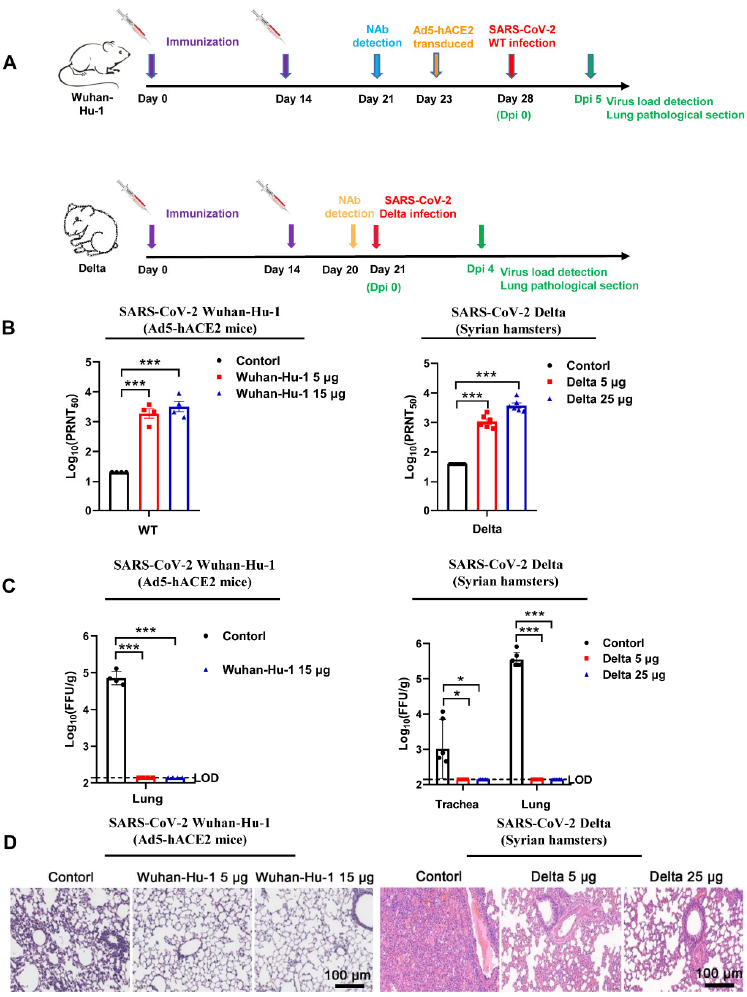
Figure 2. The Wuhan-Hu-1 and Delta vaccines exerted robust protection against SARS-CoV-2. ( A ) Experimental strategy. ( B ) Ad5-hACE2 mice (Wuhan-Hu-1; left panel) or Syrian hamsters (delta; right panel) were immunized twice with low-dose (5 µ g/dose) or high-dose (15 or 25 µ g/dose) of Wuhan-Hu-1 or Delta vaccine on day 0 and 14. The neutralizing antibody titers against SARS-CoV-2 in animals were tested by PRNT. Ad5-hACE2 mice, n = 4. Syrian hamsters, n = 6. *** p < 0.001 ( C ) Ad5-hACE2 mice or Syrian hamsters in the low- and high-dose groups were challenged with SARS-CoV-2 Wuhan-Hu-1 or Delta. The viral load was analyzed and expressed as FFU per gram of tissue in the lung (Ad5-hACE2 mice; at 4 dpi; left panel) or both lungs and trachea (Syrian hamsters; at 5 dpi; right panel). LOD, Low-limit of Detection. Ad5-hACE2 mice, n = 4. Syrian hamsters, n = 6. * p < 0.05, *** p < 0.001 ( D ) H&E staining was used to examine the histopathological changes in lung tissues in Ad5-hACE2 mice (Wuhan-Hu-1; at 4 dpi; left panel) or Syrian hamsters (Delta; at 5 dpi; right panel). Scale bar, 100 µ